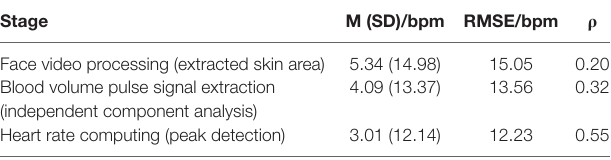
table 2 | Obtained performance for the best method at each stage.